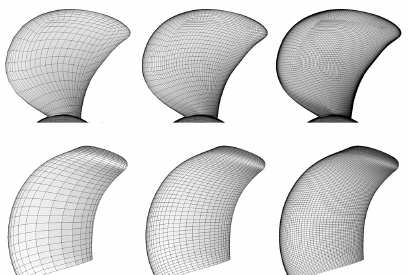
Figure 4. Grid density on the suction sides of the PPTC (top row) and TLP (bottom row) propeller blades. Coarse (left), medium (middle), and fine (right) model-scale grids shown. The whole computational domains are considered as rotating with the given rate of